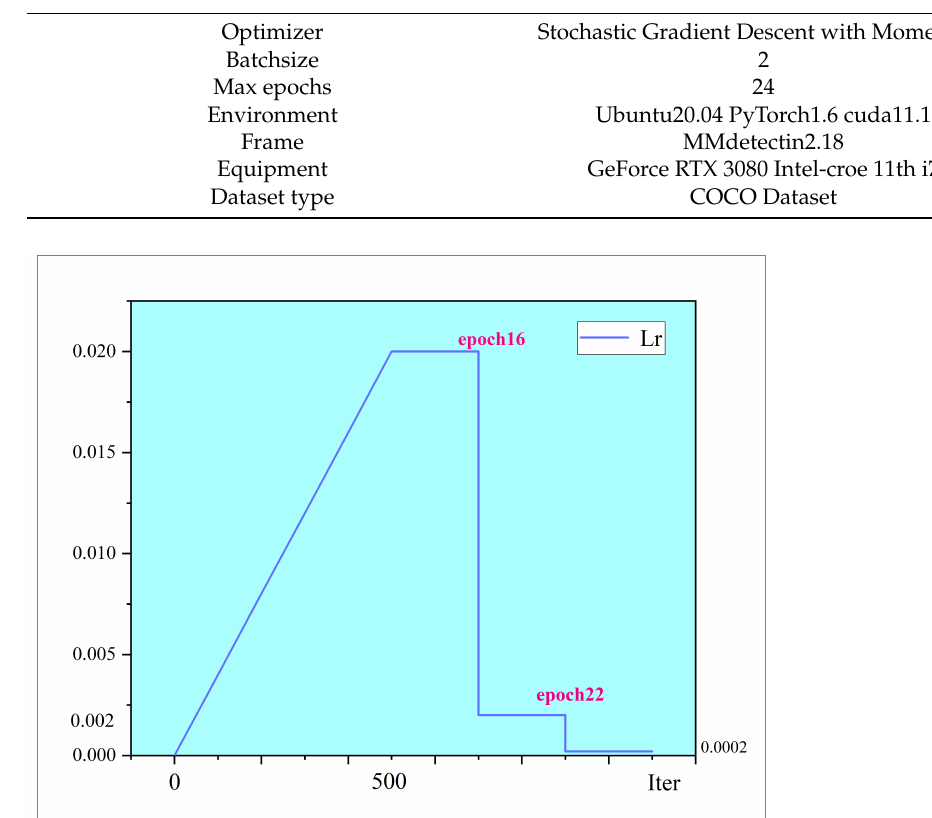
Figure 7. Learning rate settings. The learning rate increases linearly to 0.02 for the first 500 iterations and decreases to 10% at epoch 16 and epoch